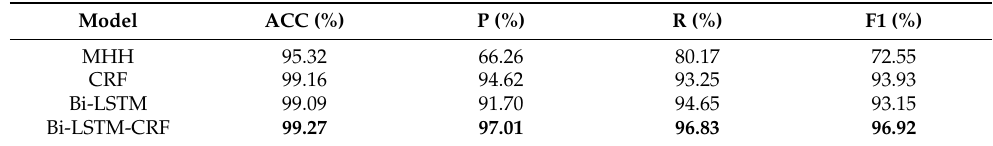
Table 4. The test results of the entity extraction